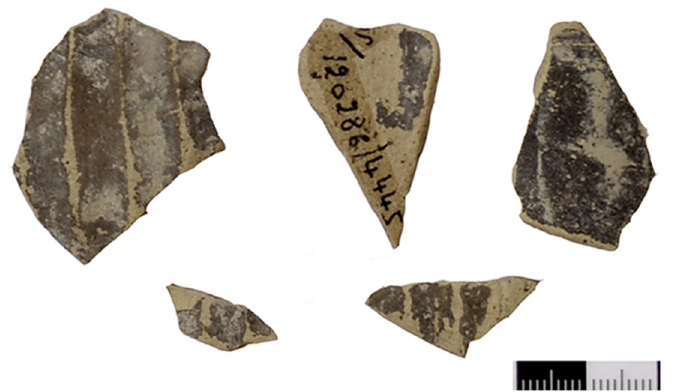
Fig 42. Body sherds of a juglet, Black Slip